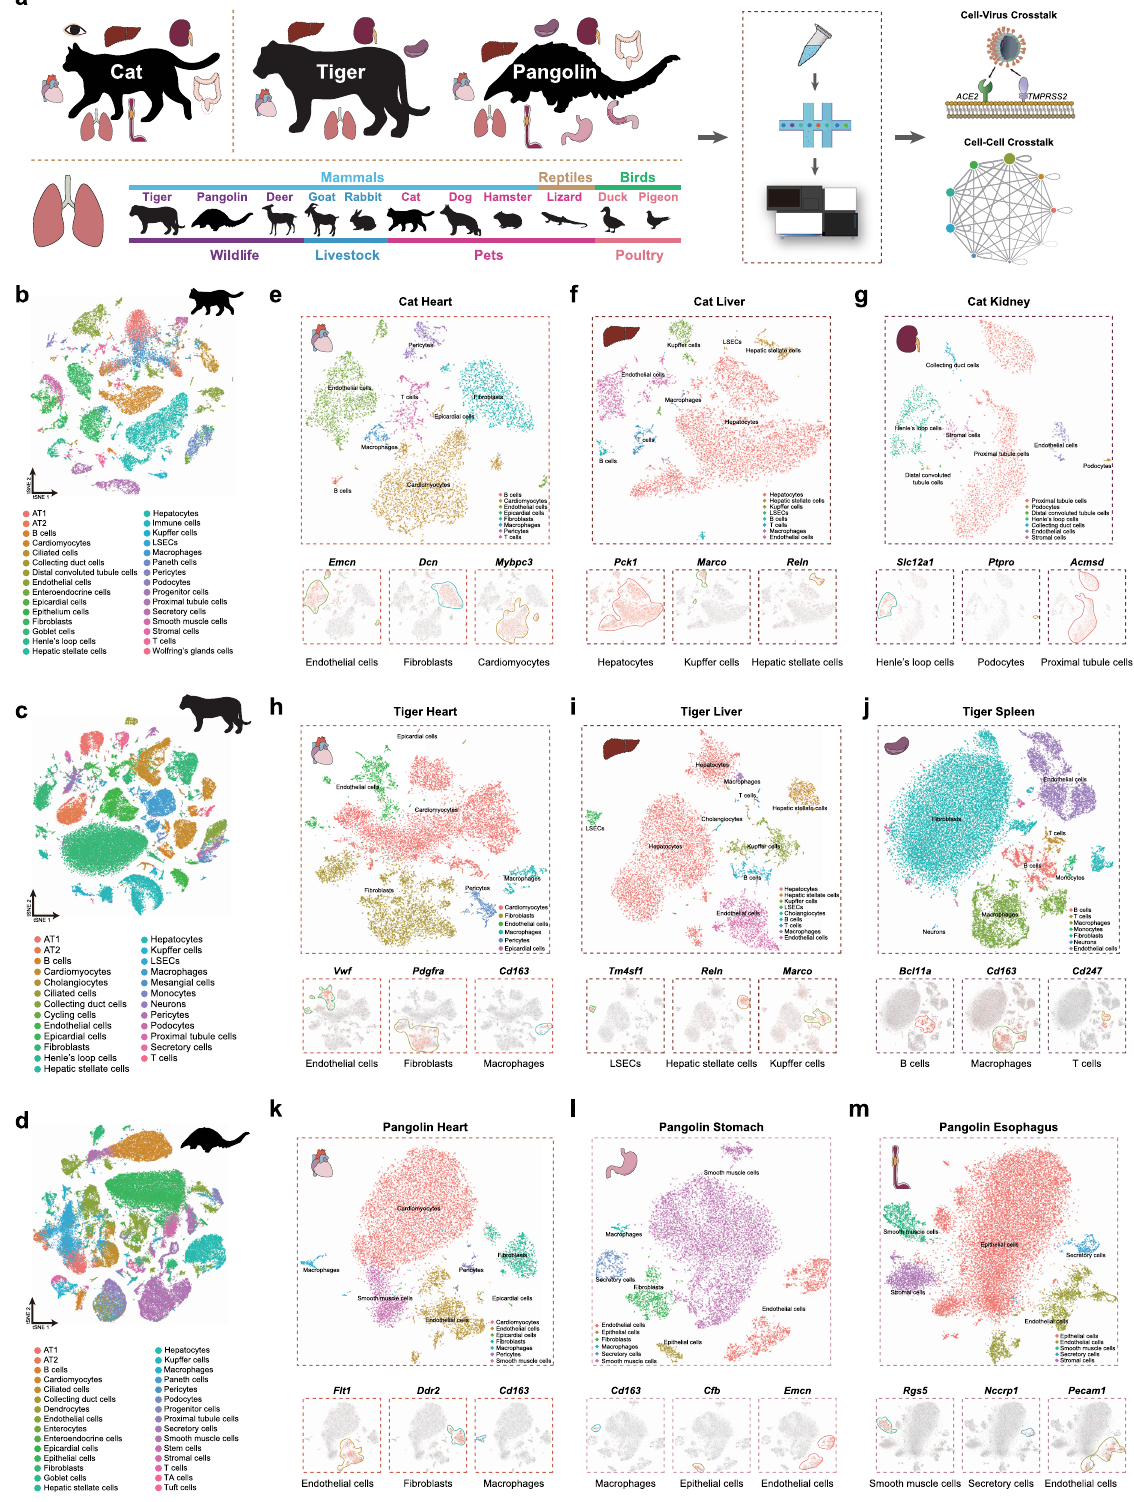
proximal tubule cells, and stromal cells), heart (epicardial cells), eyelid (endothelial cells, epithelial cells, and Wolfring ’ s glands cells), rectum (enteroendocrine cells) (Fig. 2b, d), and lung (AT2 cells, ciliated cells, endothelial cells, fi broblasts, and secretory cells) (Fig. 3b – d). Notably, we observed the co- expression of ACE2 and TMPRSS2 in over 40% of kidney